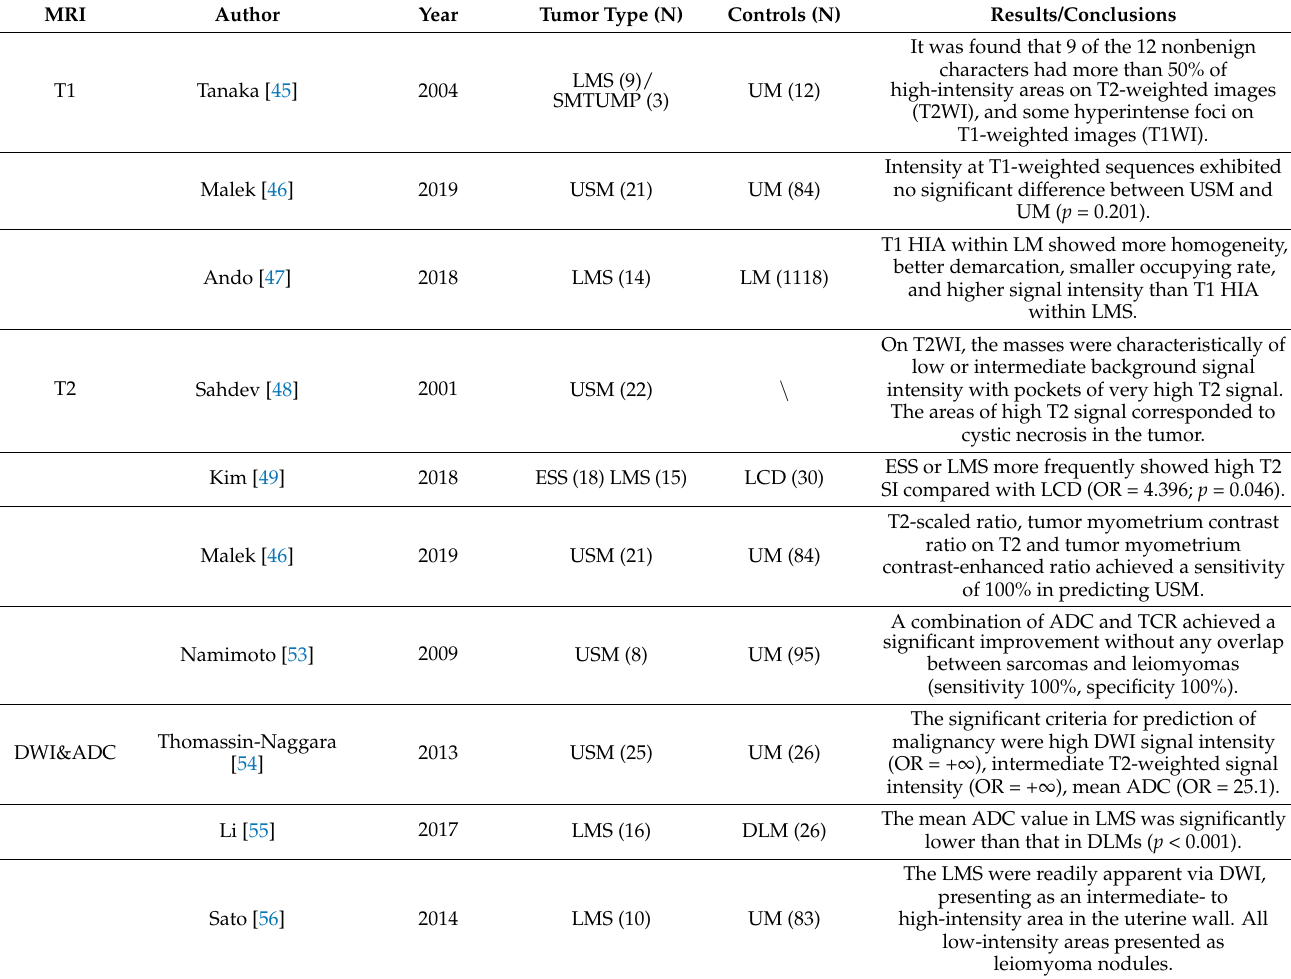
Table 2. Summary of MRI